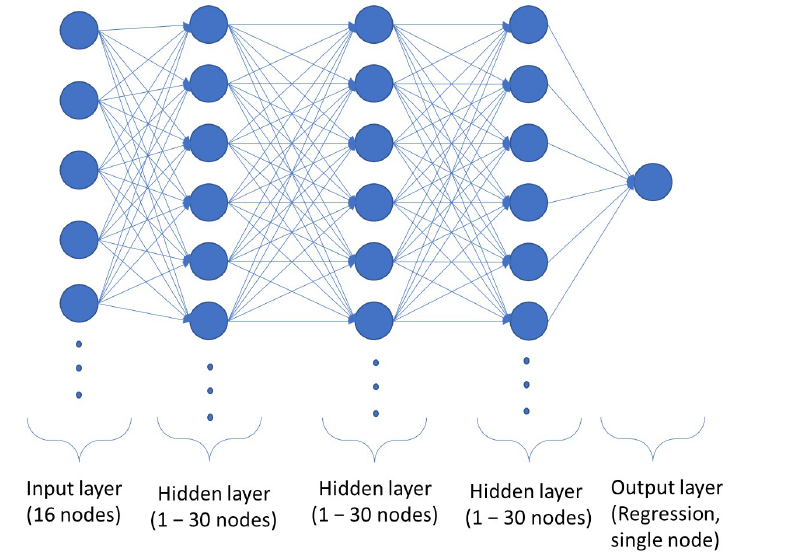
Figure 3. DNN model structure with three fully connected hidden